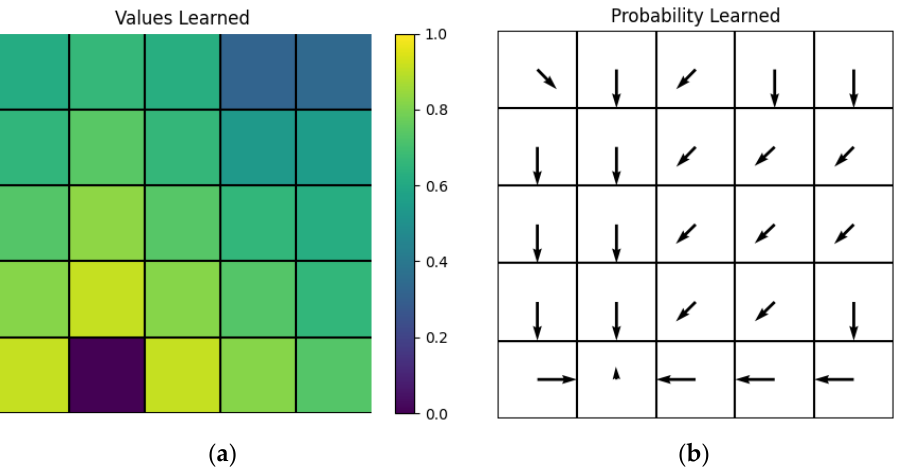
Figure 7. The results of actor-critic learning: ( a ) The values’ color map learned by critic; ( b ) The probability arrow map learned by actor.